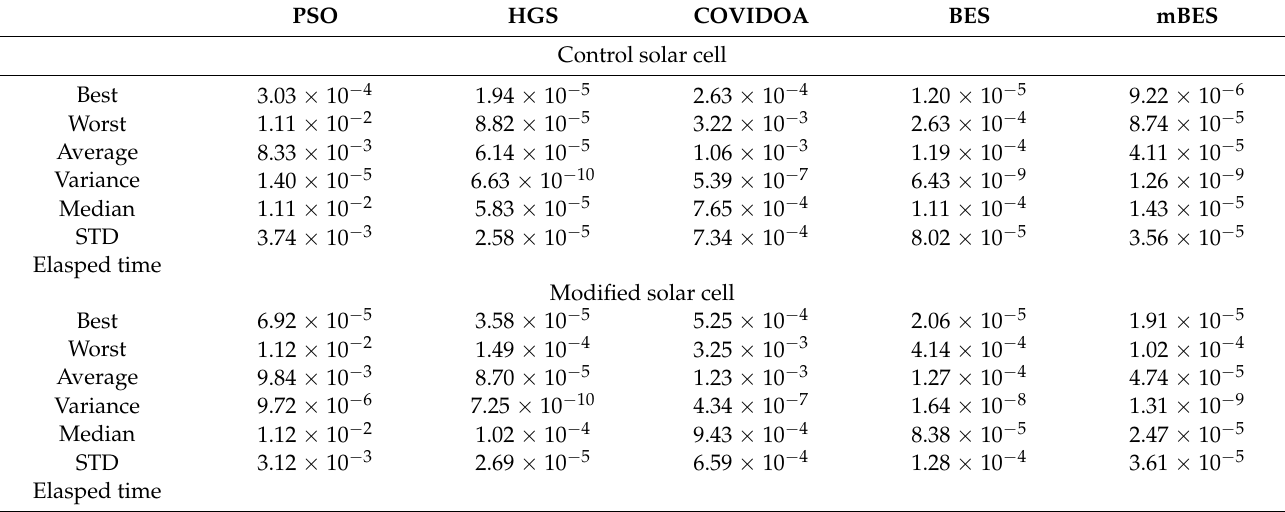
Table 3. Statistical performance evaluation of different algorithms (30